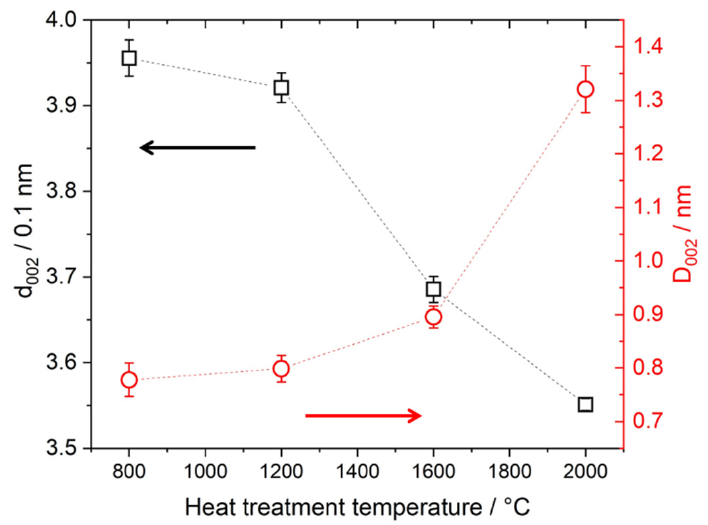
Figure 4. Result from the evaluation of wide-angle diffraction curves of organosolv lignin-based samples. The lattice spacing d 002 (black squares, left axis) and the size of coherently scattering domains in the (002) direction D 002 (red circles, right axis) are displayed. The connecting lines are for guiding the eye only, the arrows additionally indicate the corresponding axis. The errors indicated result from the fitting errors—the error of d 002 at 2000 °C is within the displayed square and therefore not visible.